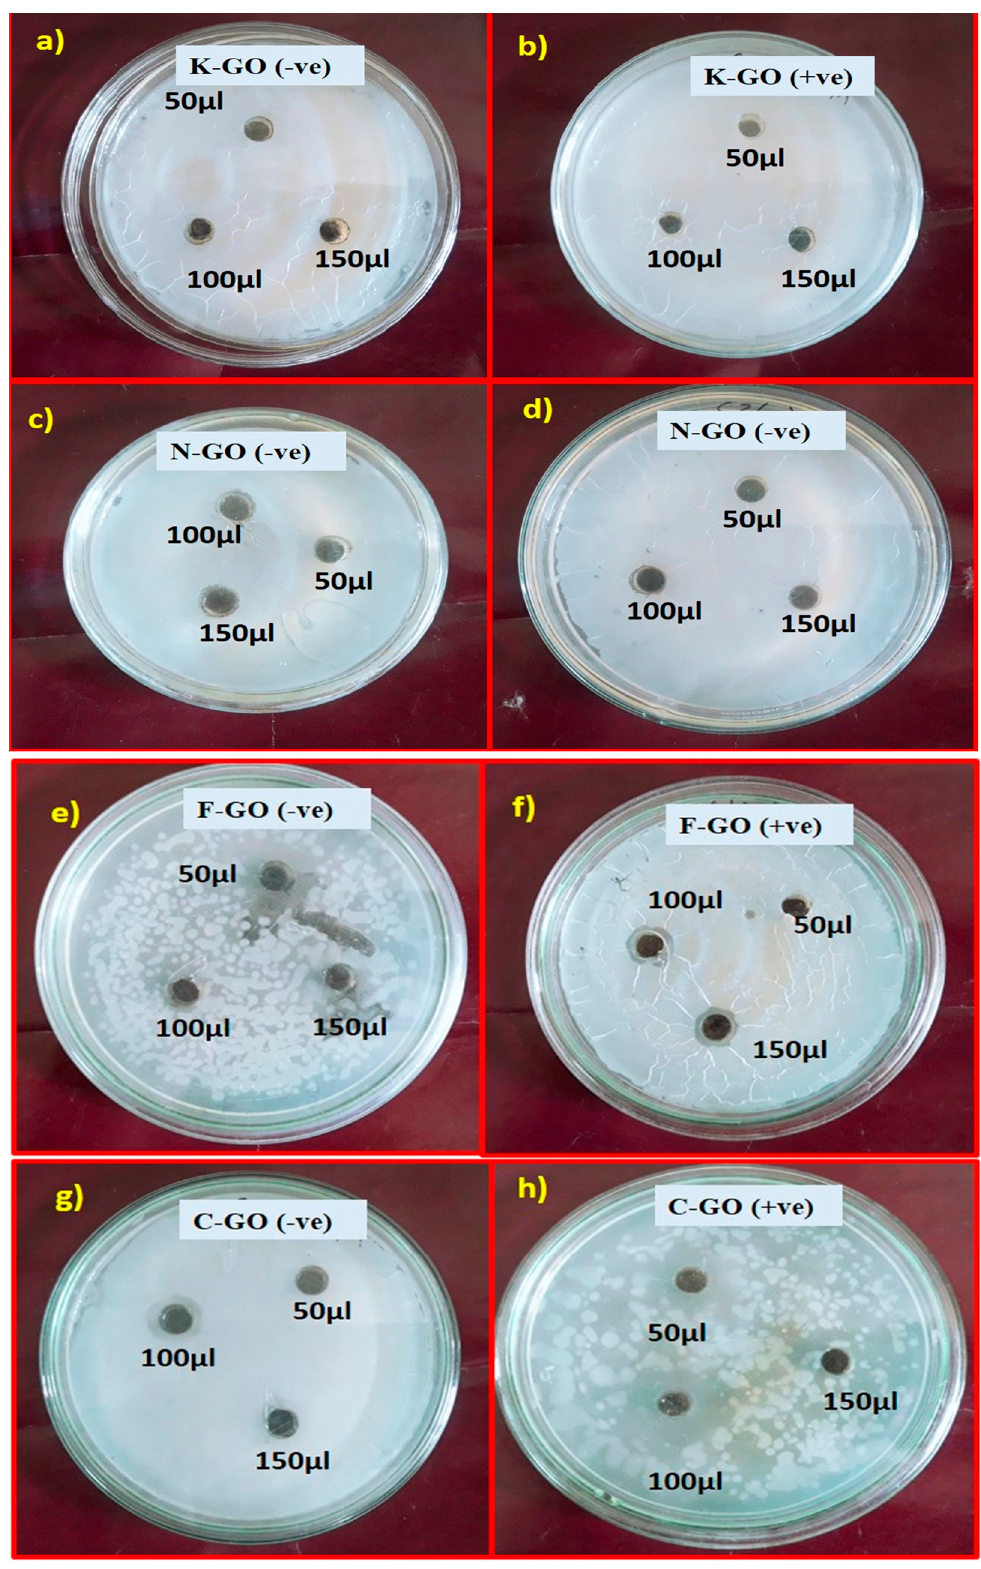
Figure 7. Antibacterial activity test against Pseudomonas pneumonia and Staphylococcus aureus with GO NS in different concentrations in methanol (50, 100, and 150 μ g/mL). ( a ) K–GO ( − ve), ( b ) K–GO (+ve), ( c ) N–GO ( − ve), ( d ) N–GO (+ve), ( e ) F–GO ( − ve), ( f ) F–GO (+ve), ( g ) C–GO ( − ve), ( h ) C–GO (+ve). Effect of Dose Concentration